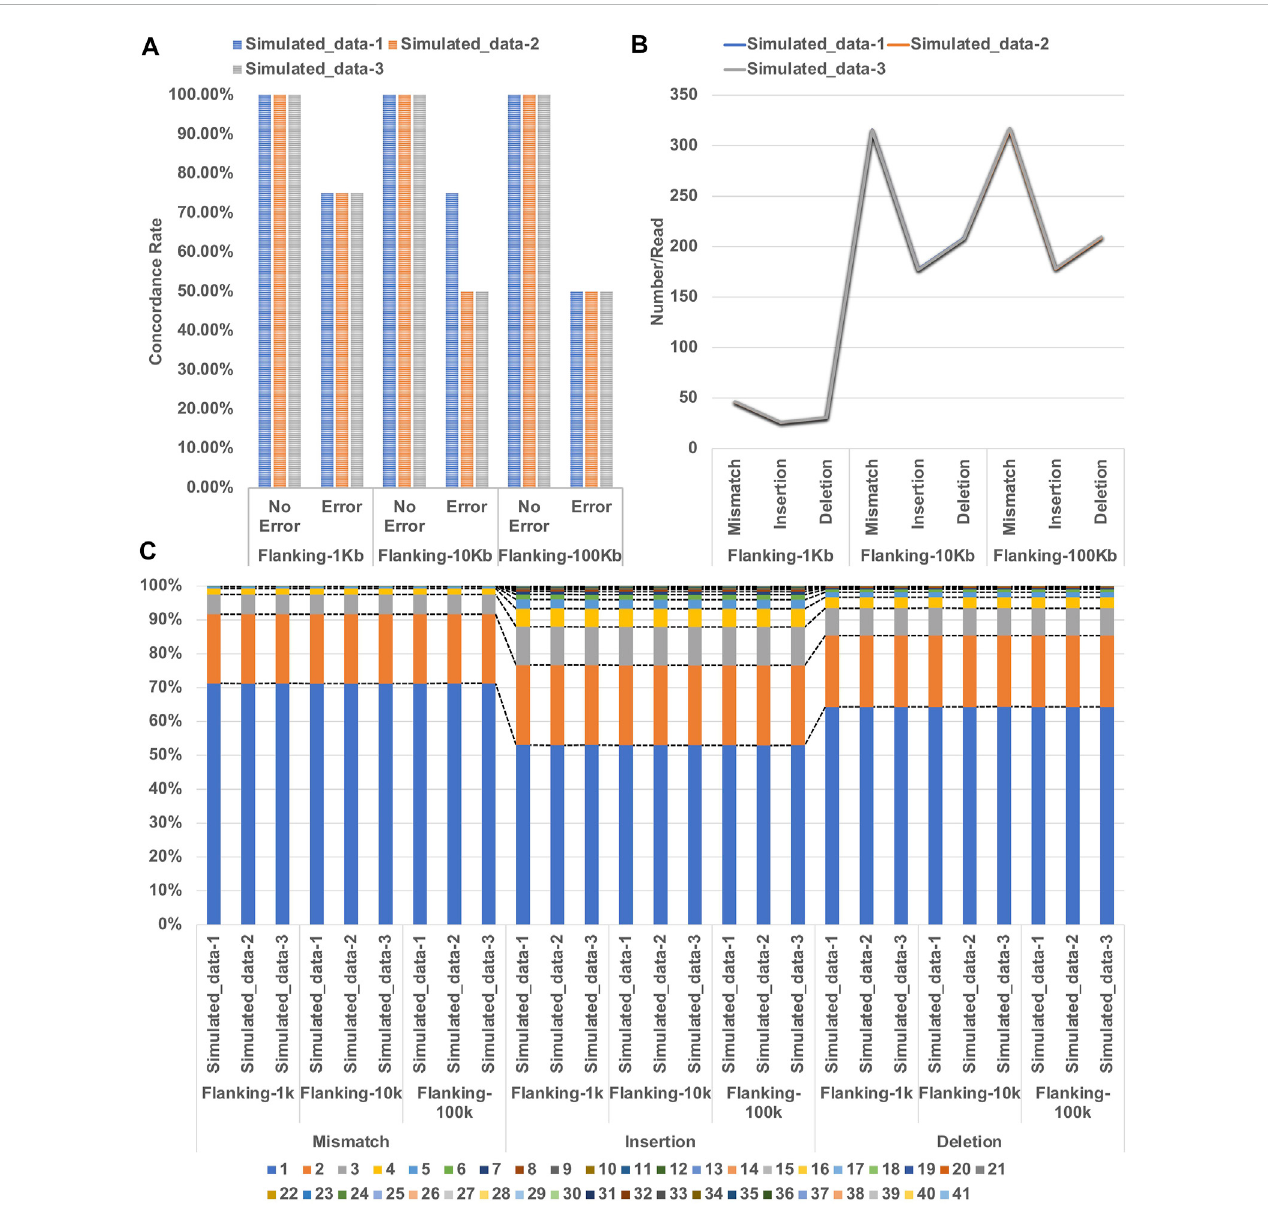
FIGURE 2 (A) Concordance of STR typing with the three simulated datasets of Flanking 1 kb, Flanking-10 kb, and Flanking-100 kb (B) error number averaged over reads; and (C) proportions of the lengths of each error